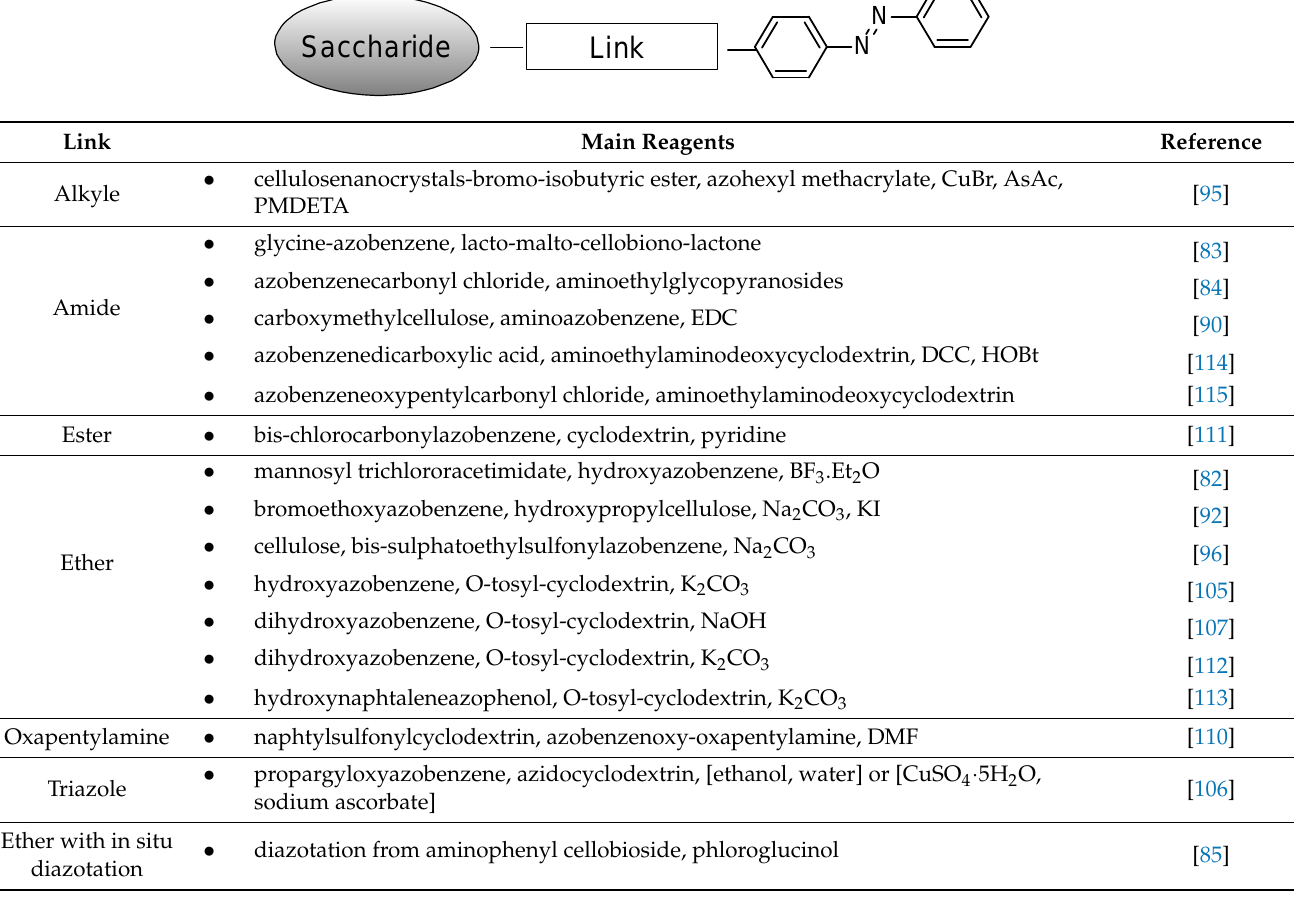
Table 2. Links between azo moieties and oligosaccharides and reagents used to obtain these links.